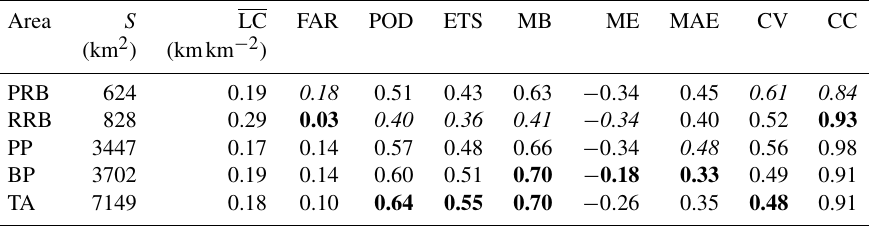
Table 5. Values of the statistical indicators for the mean rain amounts over each considered area, shown in ascending order of surface area S . Values in bold (italics) are the best (worst) values in the column. Area